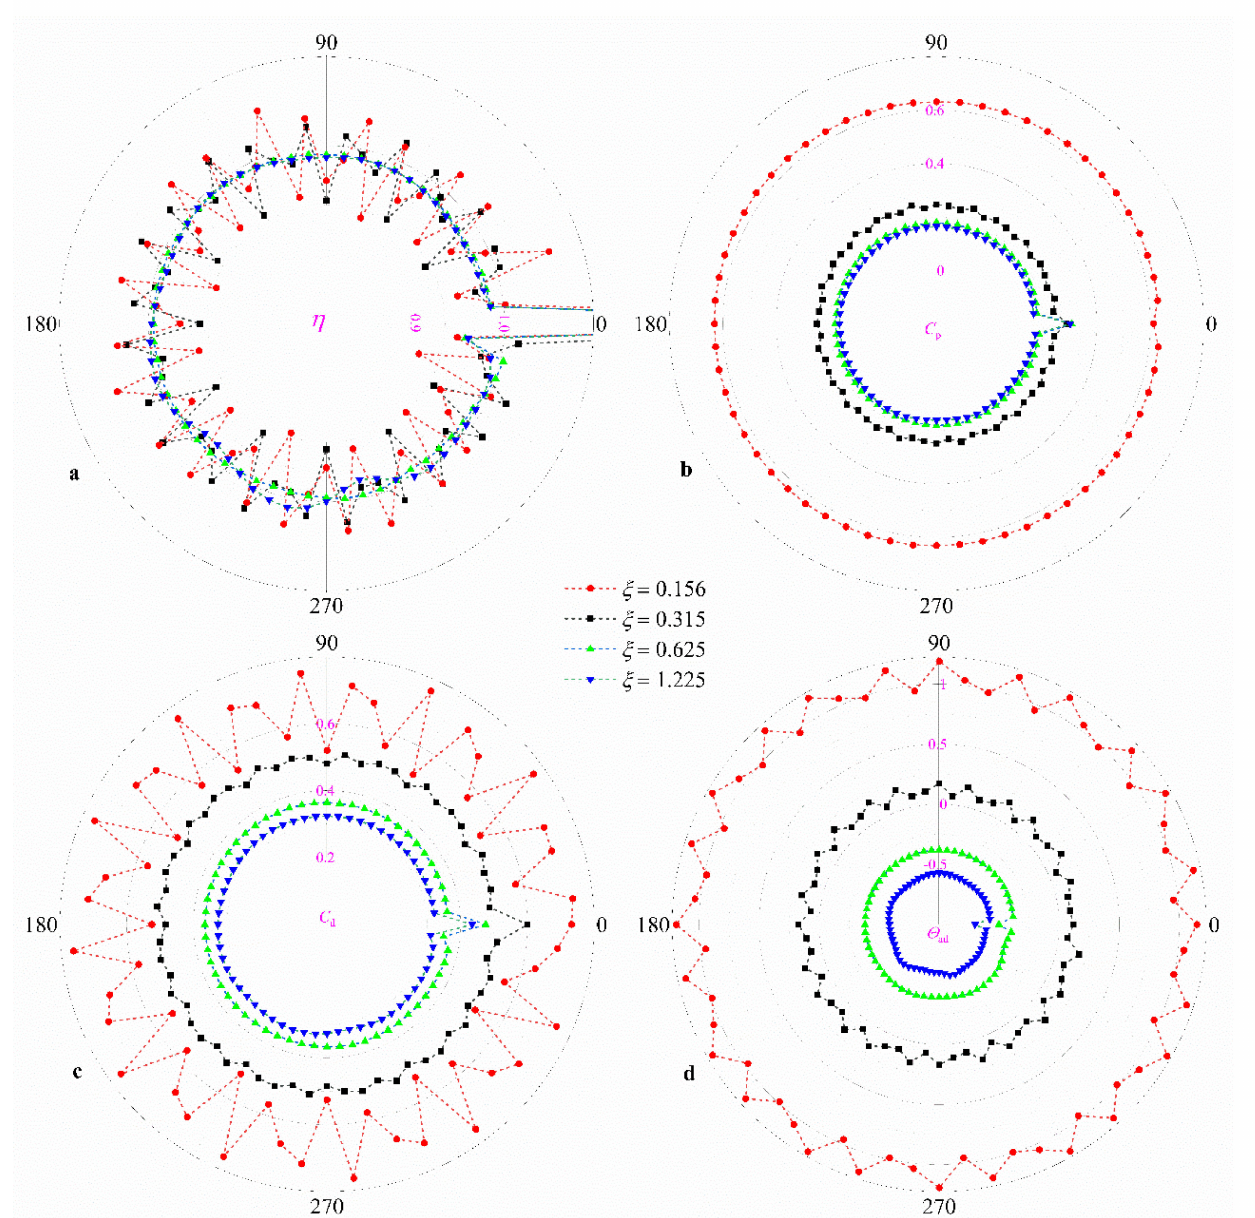
Figure 12. Distribution of ( a ) mass-flow-rate ratio η , ( b ) total-pressure-loss coefficient C p , ( c ) discharge coefficient of holes C d , and ( d ) adiabatic effectiveness Θ ad for different area ratios of nozzles to holes ξ